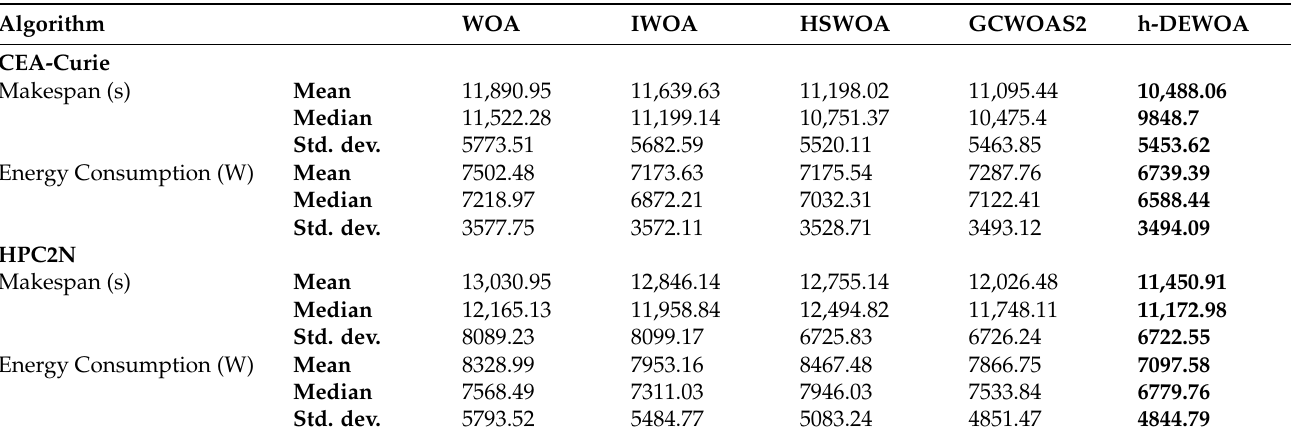
Table 10. Summary of overall results of scheduling algorithms for CEA-Curie and HPC2N workloads for the first set of experiments.